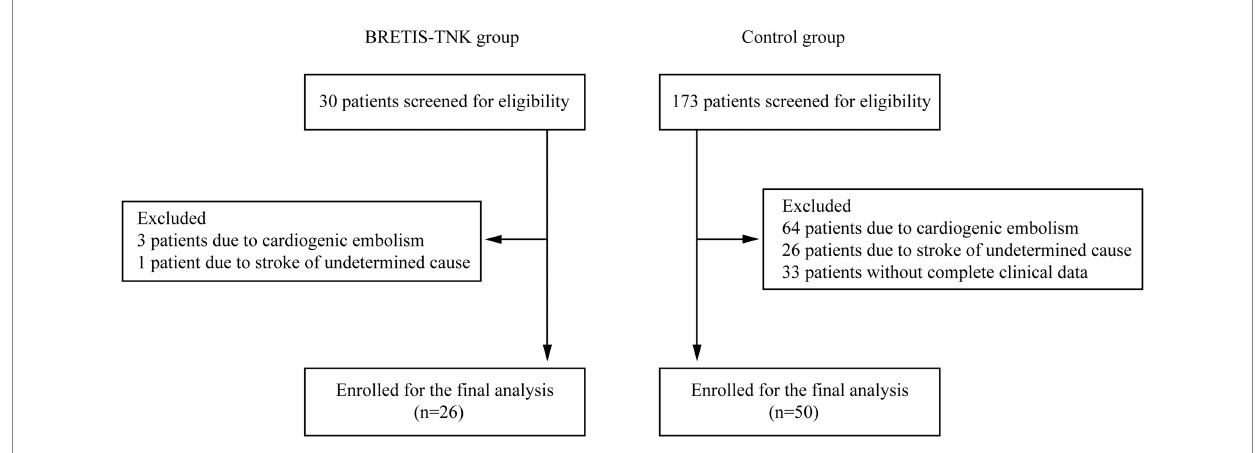
FIGURE 2 Flowchart of patient